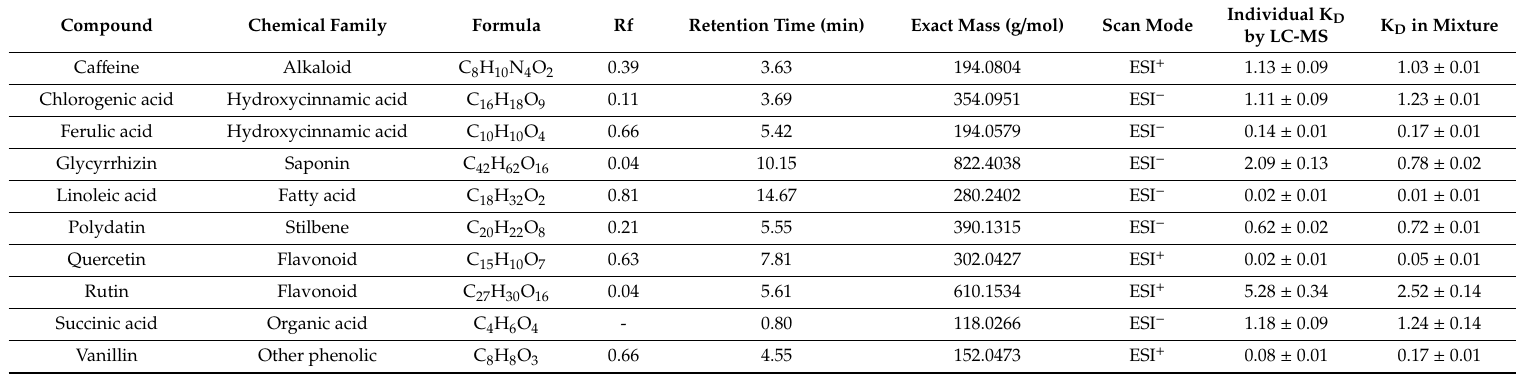
Table 1. Analytical standards selected for the measurement of their distribution coe ffi cients (K D ) individually and as a mixture in the biphasic system EtOAc / CH 3 CN / water 3:3:4 ( v / v / v ). Their thin-layer chromatography (TLC) retardation factor (Rf) with EtOAc / toluene / acetic acid / formic acid 6:4:1:1 ( v / v / v / v ) as elution solvents, retention time and scan mode chosen are listed. Each LC-MS analysis was performed in triplicate. ESI: Electrospray